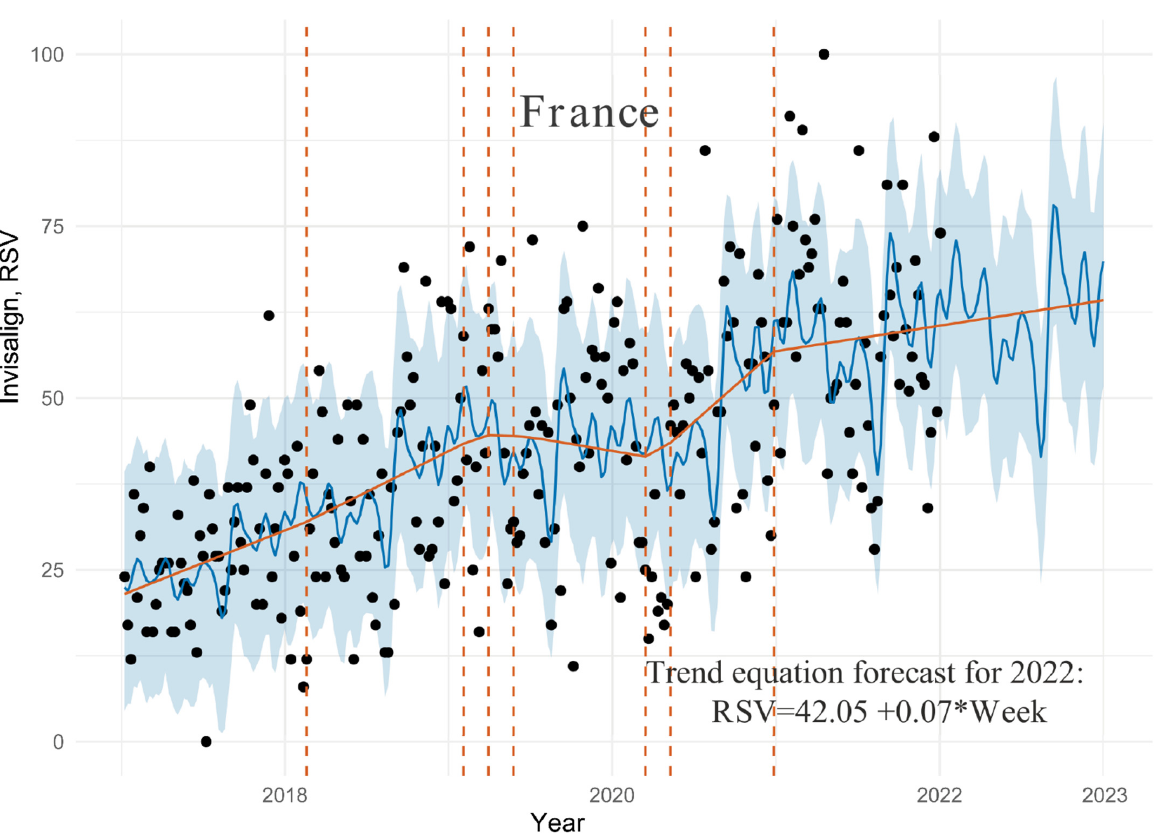
Figure 2. Graph of GT time series distribution for search results for keyword “Invisalign” in France with the fit and prediction by Prophet algorithm and trend equation forecast for 2022, where “Week” is the week number counted from the beginning of dataset (8 January